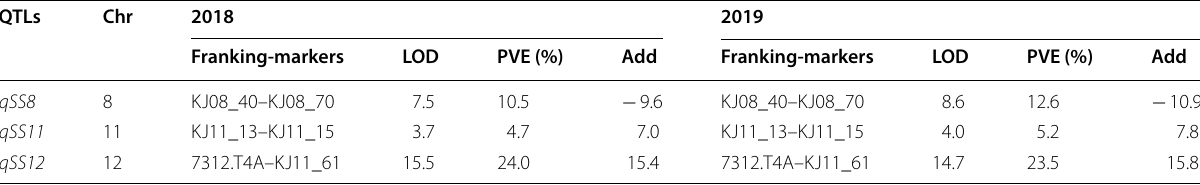
Table 2 QTLs associated with spikelet fertility of 225 lines detected by composite and interval mapping